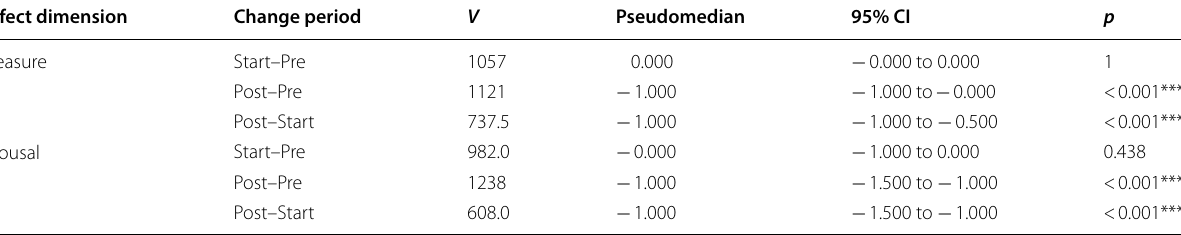
Table 2 Changes in arousal and pleasure scores across study parts (all materials combined)—results of the Wilcoxon signed rank